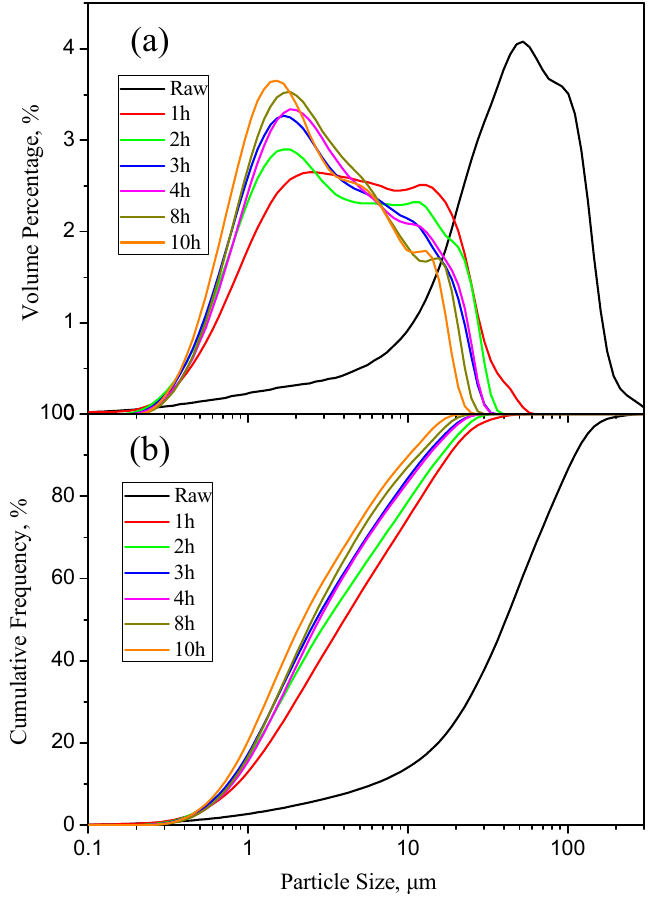
Figure 4. Evolution in the particle size distribution during milling: ( a ) 0–3 h; ( b ) 3–10 h.